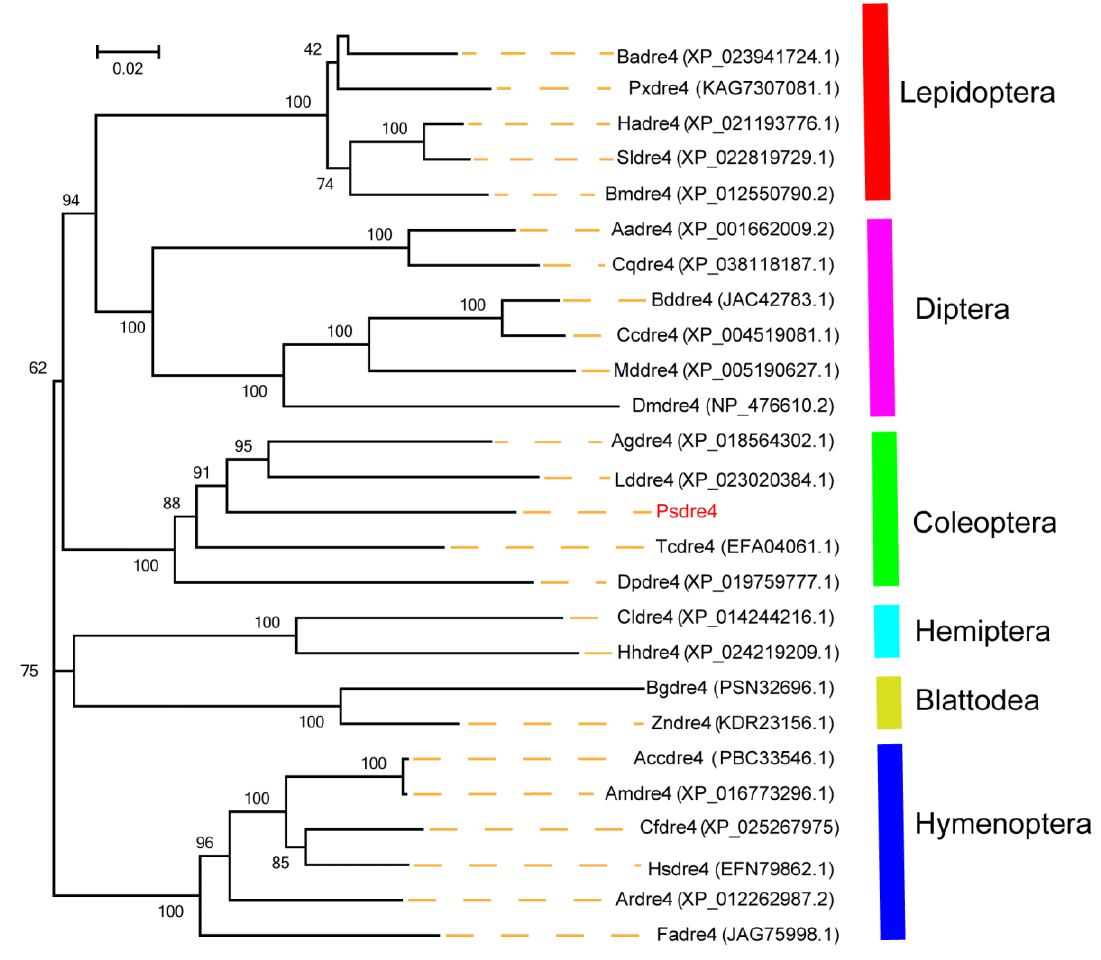
Figure 1. Phylogenetic tree of dre4 ortholog sequence from 27 insect species. The neighbor-joining phylogenetic tree was generated using the MEGA 5.0 program and bootstrap values from 1000 trials. NCBI GenBank accession numbers are indicated in parentheses. Abbreviations: 1. Lepidoptera (At, Amyelois transitella ; Ba, Bicyclus anynana ; Px, Plutella xylostella ; Ha, Helicoverpa armigera ; Sl,